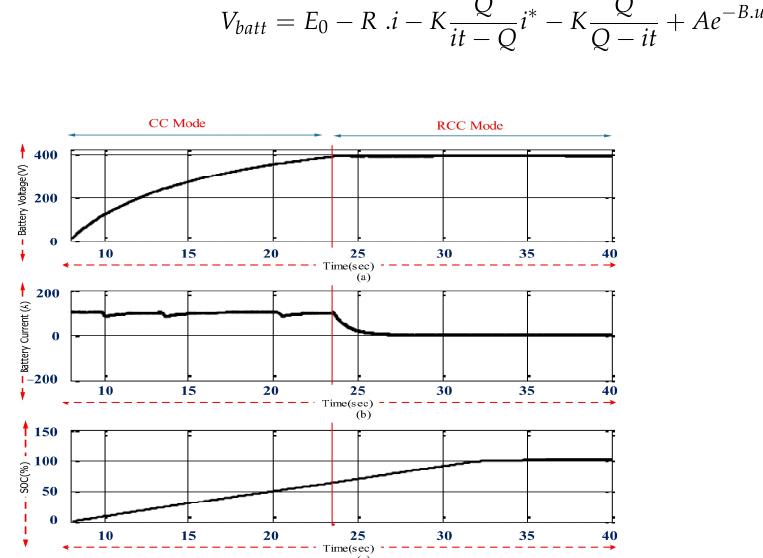
Figure 7. Battery charging waveforms in the charging method RCC/CC: ( a ) battery voltage; ( b ) battery current; ( c ) battery charging status with SOC.